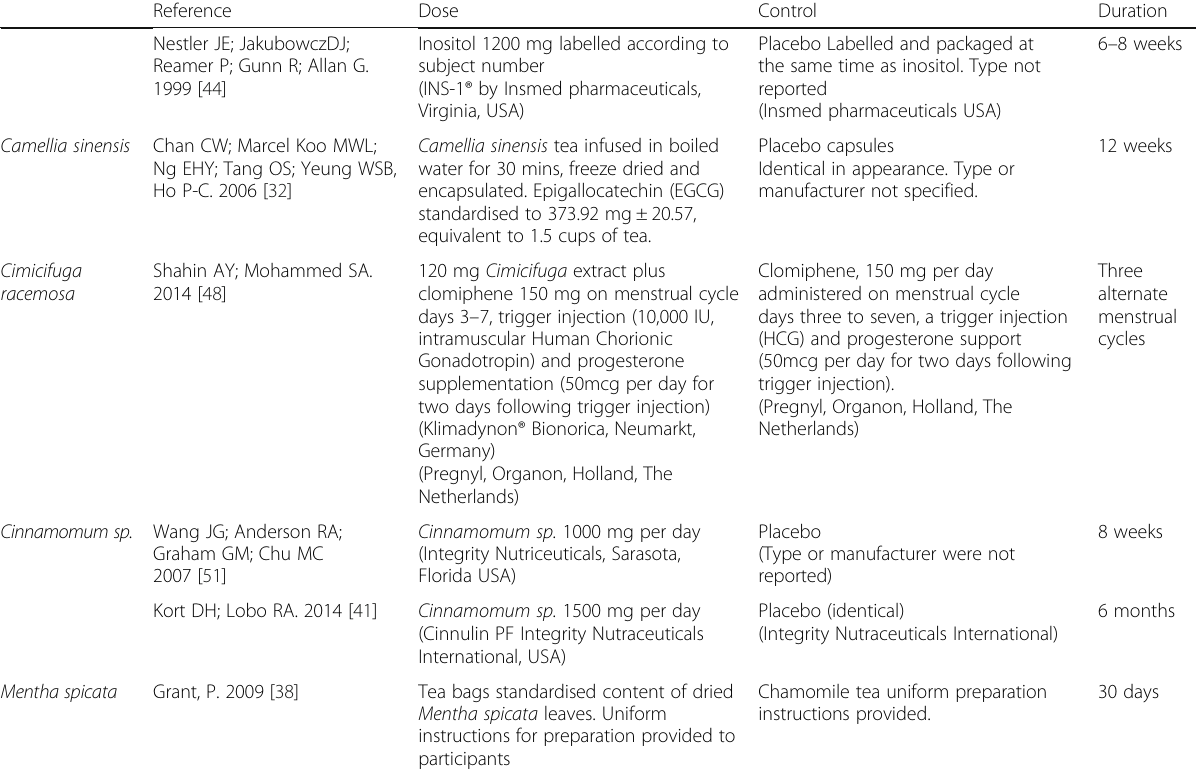
Table 1 Interventions: Nutritional supplements and herbal medicine